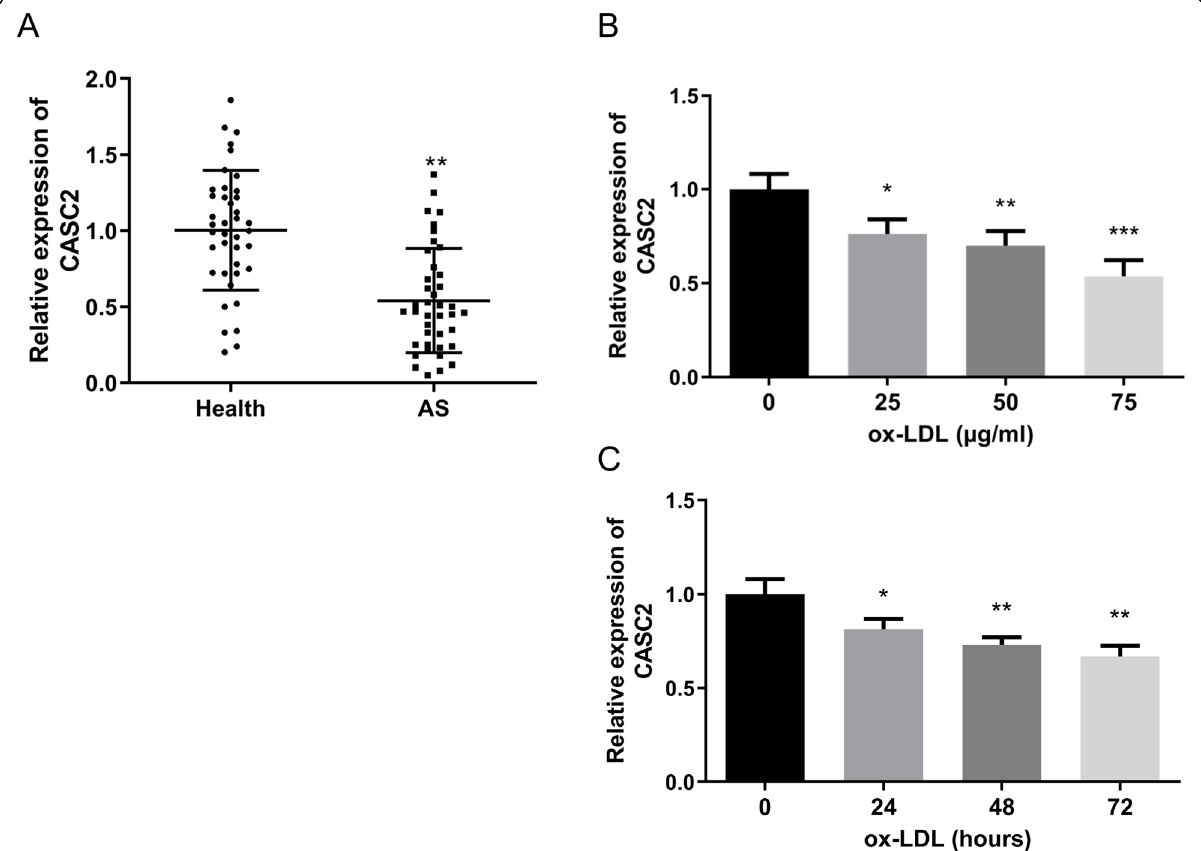
Fig. 1 LncRNA CASC2 was downregulated in AS patient serum and ox-LDL-stimulated VSMCs. a The expression of CASC2 in serum of AS patients and healthy people through qRT-PCR. b The expression of CASC2 after treatment with 0, 25, 50, 75 μ g/ml ox-LDL for 1 d. c The expression of CASC2 after treatment with 50 μ g/ml ox-LDL for 0, 1, 2, and 3 d through qRT-PCR. ** P < 0.01; *** P <